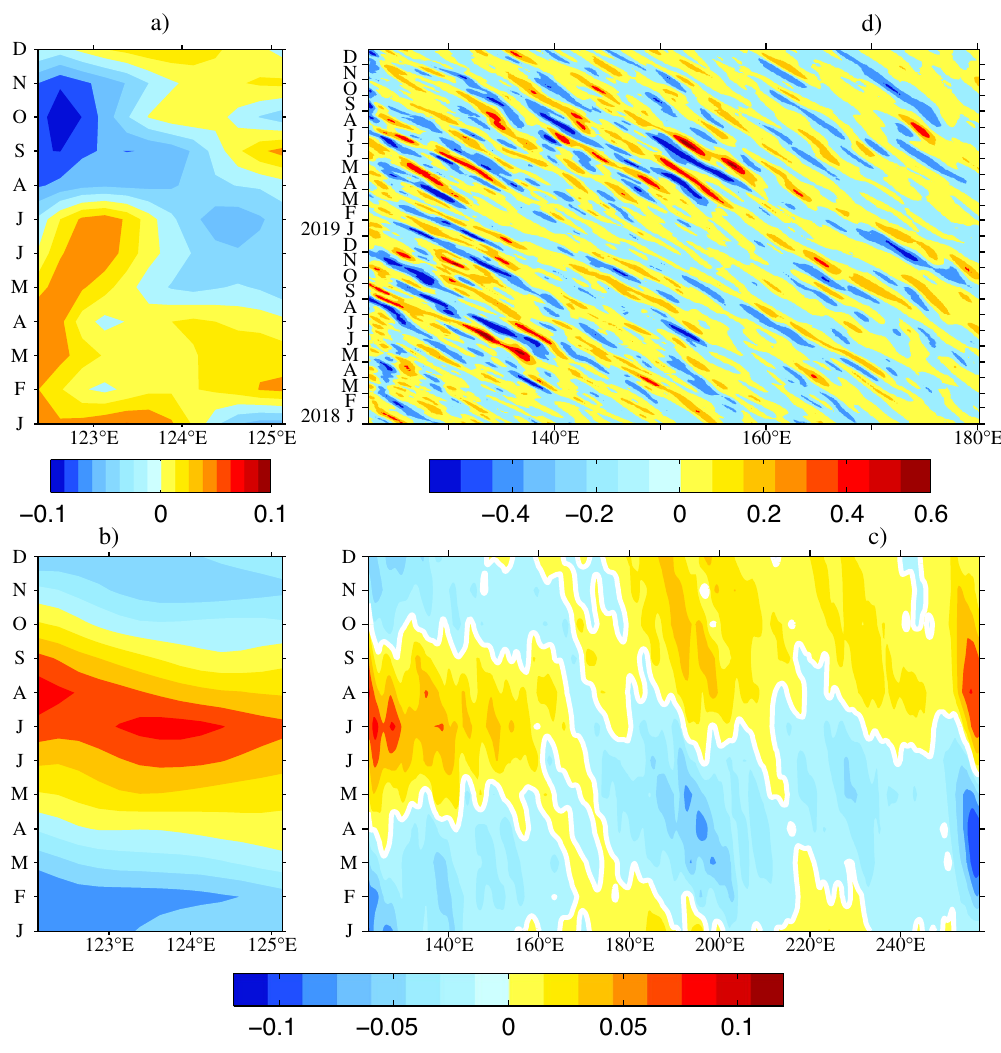
Figure 6. ( a ) Mean monthly meridional velocity anomalies (January 1993 to December 2019), and mean monthly SSHa (January 1993 to December 2019) from satellite altimeter data along 18° N ( b ) in the origin region of the KC and ( c ) across the North Pacific Ocean (units are m), and ( d ) the meridional velocity anomalies from January 2018 to December 2019 calculated from satellite altimeter data along 18° N (units are m/s). The geostrophic current anomalies are calculated from satellite altimetry (http:// www. marine. coper nicus. eu). Figures are plotted using MATLAB R2012b (http:// www. mathw orks.